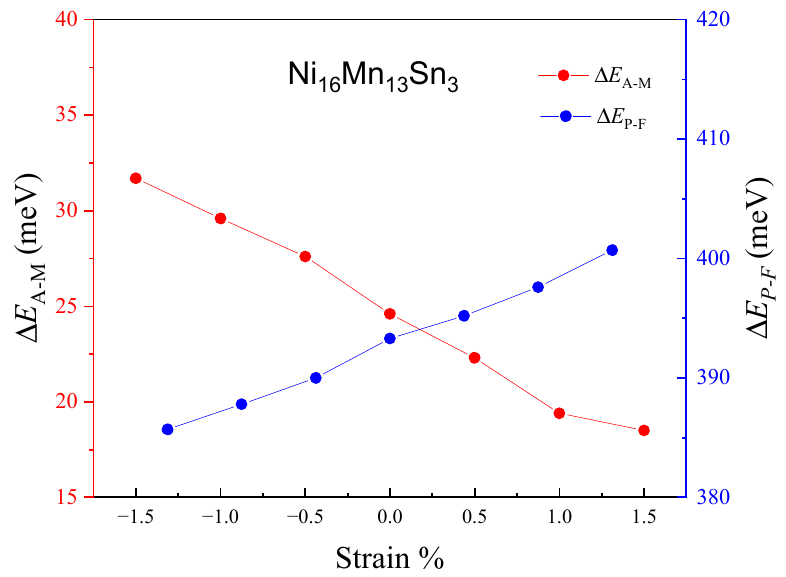
Figure 3. Strain change ( − 1.5–1.5%) of ΔΕ A-M and ΔΕ P-F for Ni 16 Mn 13 Sn 3 . In order to tune the working temperature of alloys, alloys must have stable